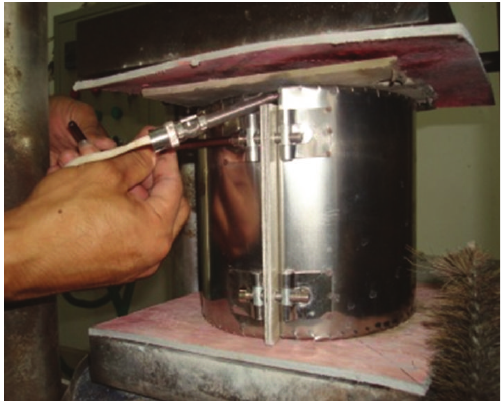
Figure 8: Cylindrical heating